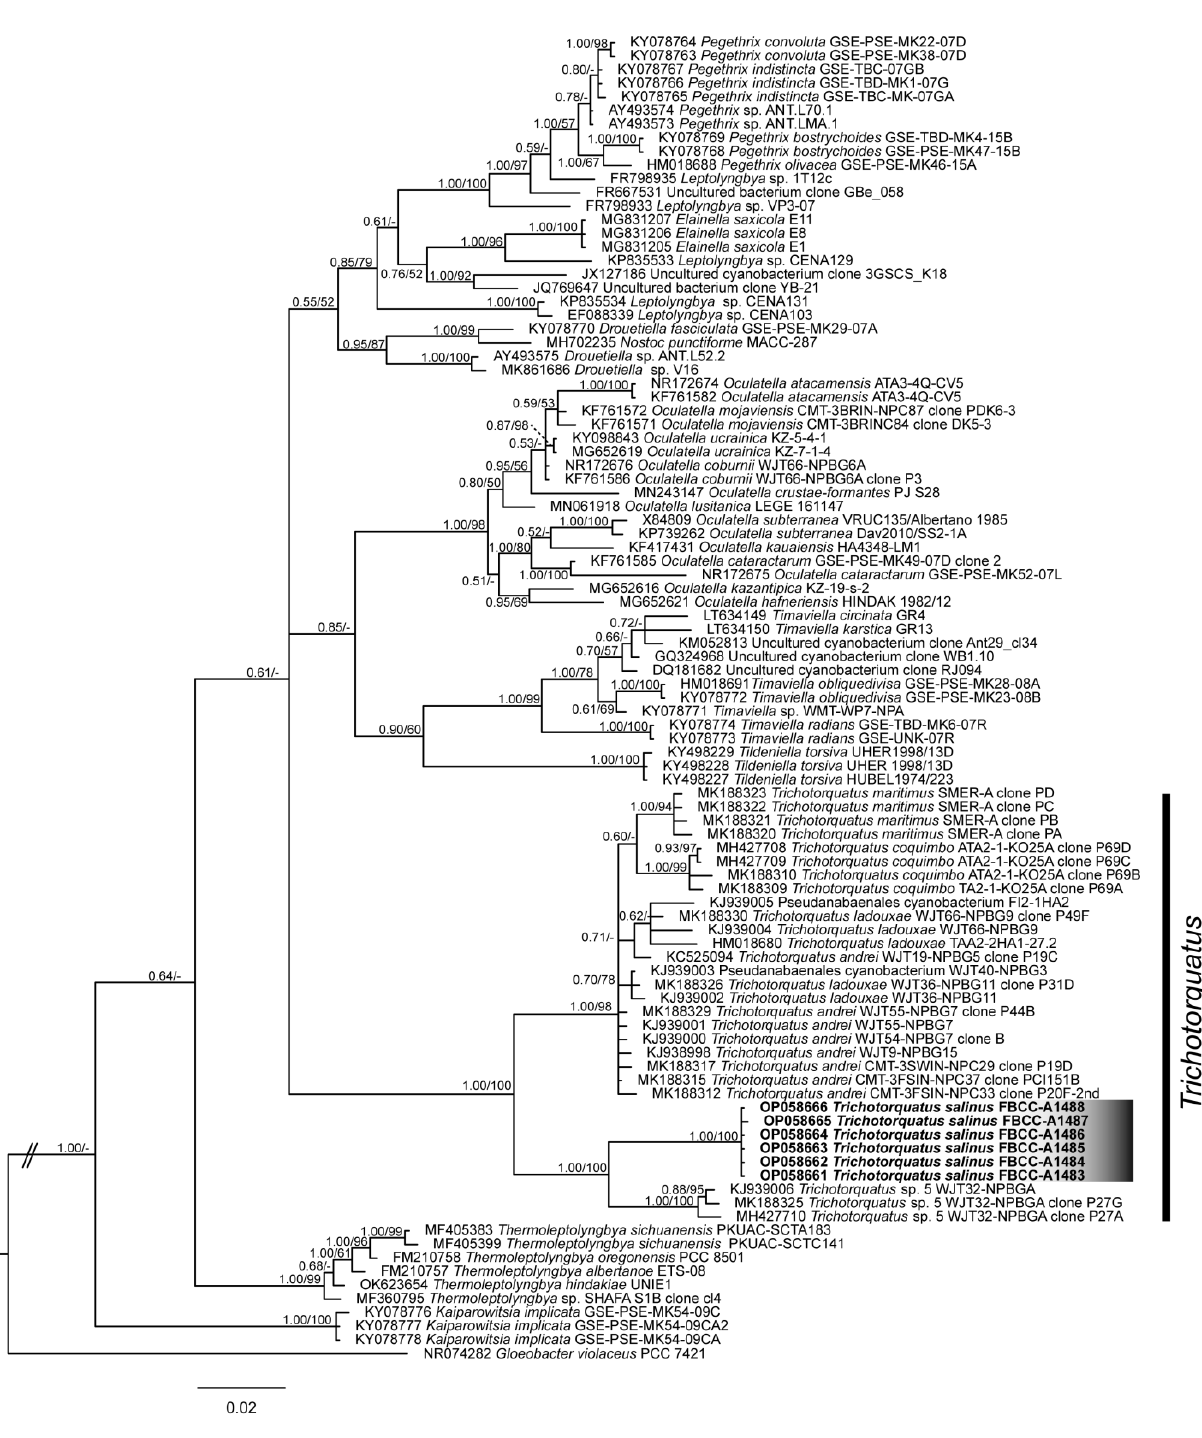
Figure 5. Consensus Bayesian tree based on species in the family Oculatellaceae with closely related unidentified taxa and Gloeobacter violaceus as an outgroup. Our strains are marked in bold. The branch lengths are proportional to the number of character changes. Posterior probabilities ( left ) and ML bootstrap values ( right ) were presented on the node. Posterior probabilities ≥ 0.5 are shown.